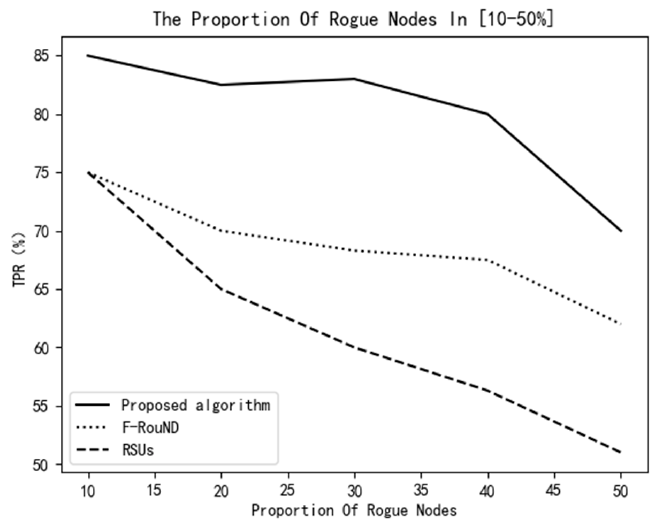
the 3 algorithms vs. the proportion of rogue nodes is shown in Figure 15.